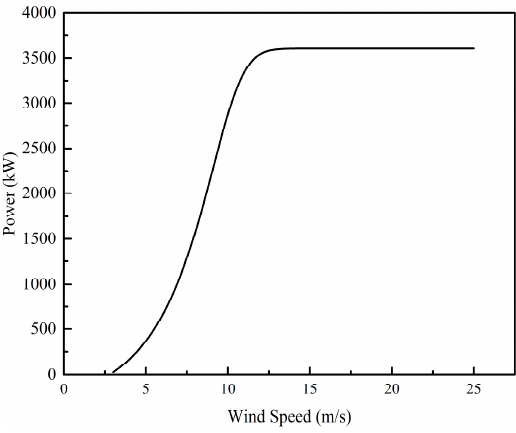
Figure 5. Power curve of the Siemens 3.6 MW.